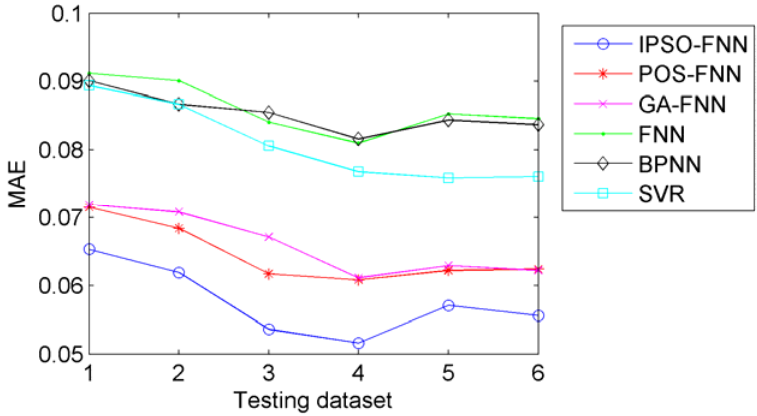
Figure 5. Comparison of mean absolute error.